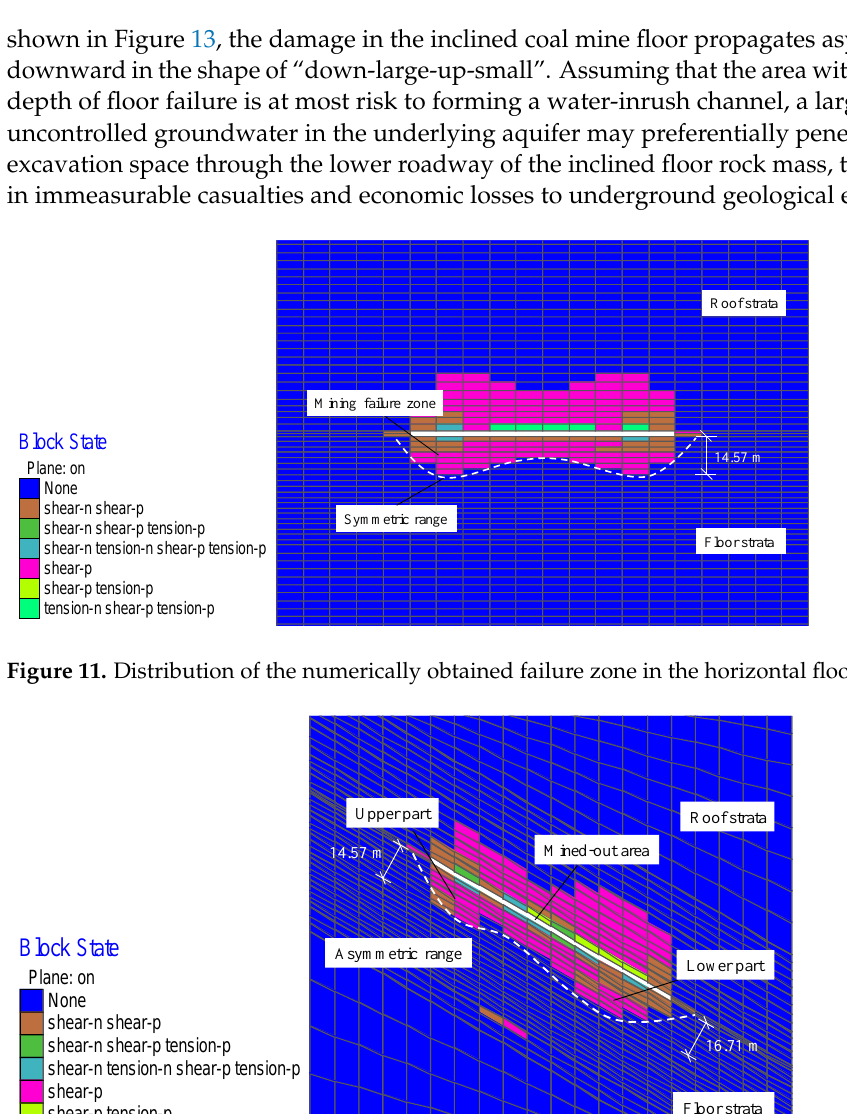
16 . 71 m Figure 10. Failure depth of the floor with varying excavation distance. Subsequent to all calculations, the failure zones in the horizontal and inclined floor rocks were further analyzed, with Figures 11 and 12 showing the profiles in the middle of the numerical models along the inclination. The numerically obtained result of Figure 11 demonstrates that the overall failure mode of the horizontal floor strata is clearly an